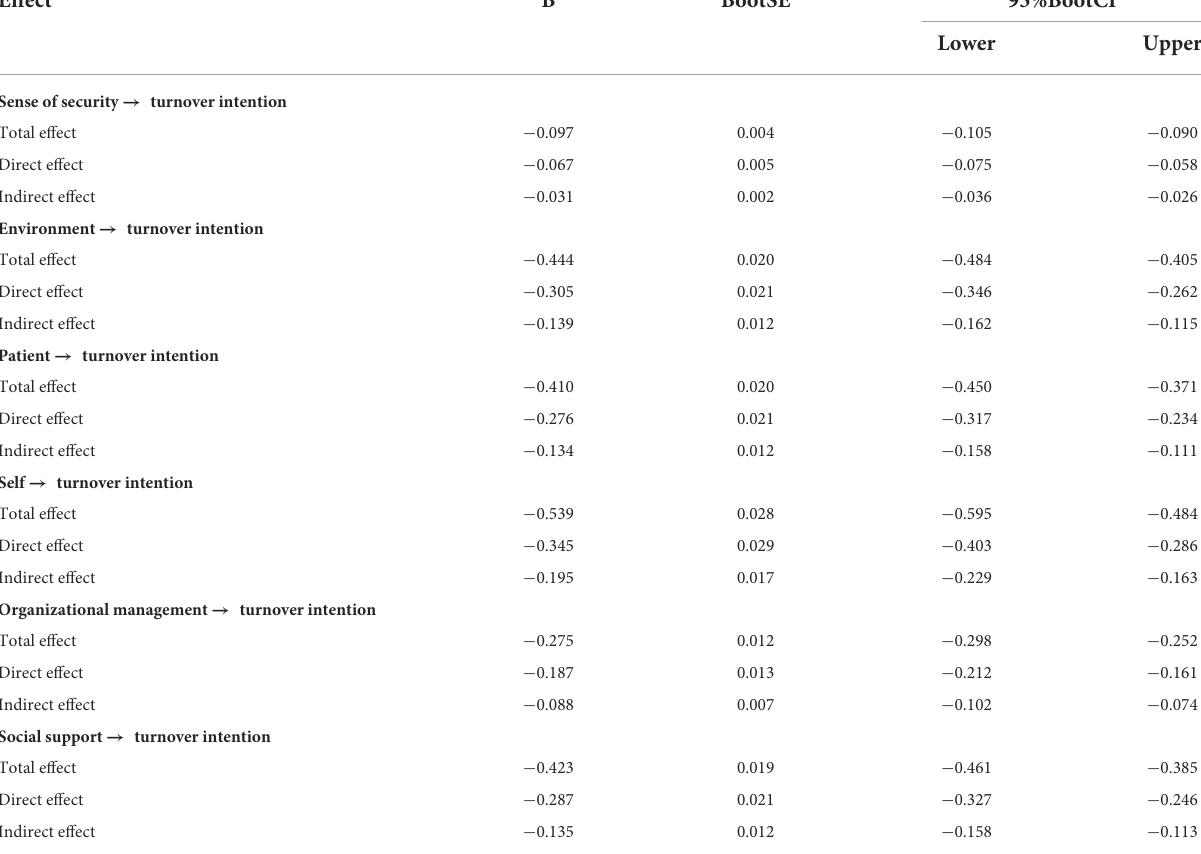
TABLE 4 Direct and indirect effects of sense of security and its dimensions on turnover intention ( N = 2480).